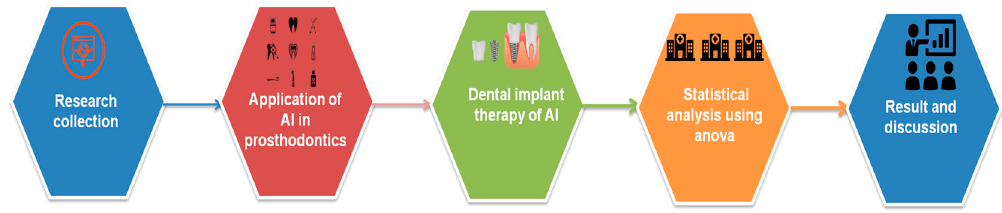
Figure 1. The flow of review methodology.